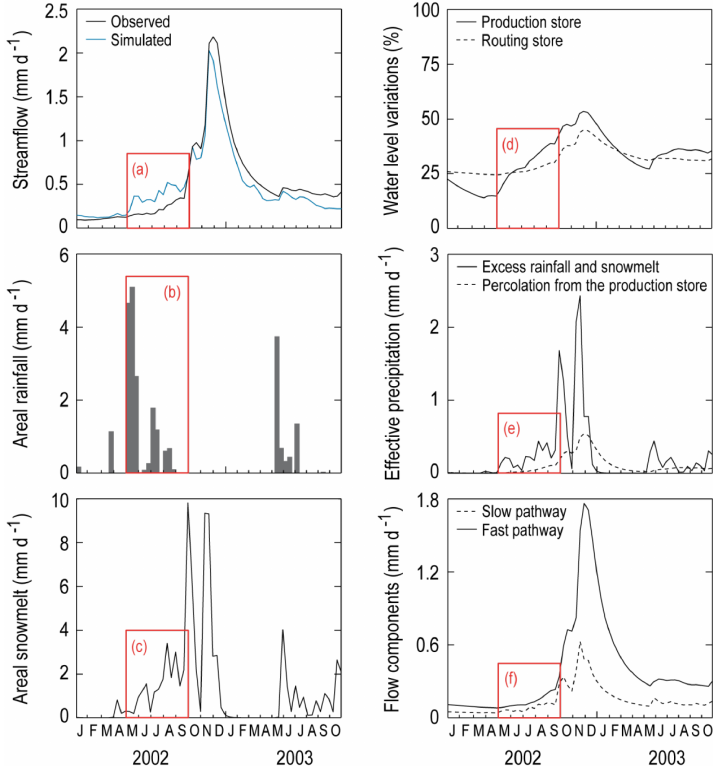
Figure 11. Internal state variables and fluxes obtained with Model C during the 2002–2003 El Niño event (using the best-performing parameter set obtained by calibration against the F obj